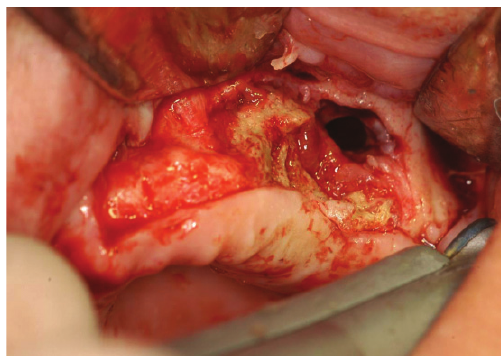
Figure 3: Bone resection and corticotomy with Er:YAG laser (Step 1): necrotic aspect of the bone is visible.